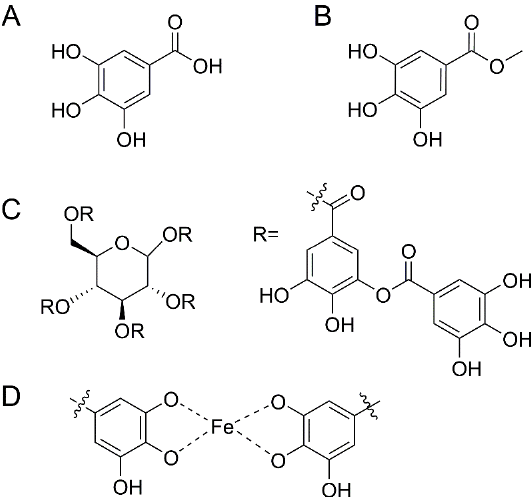
Figure 1. Chemical structures of ( A ) gallic acid, ( B ) methyl gallate, ( C ) tannic acid, and ( D ) galloyl binding of iron.